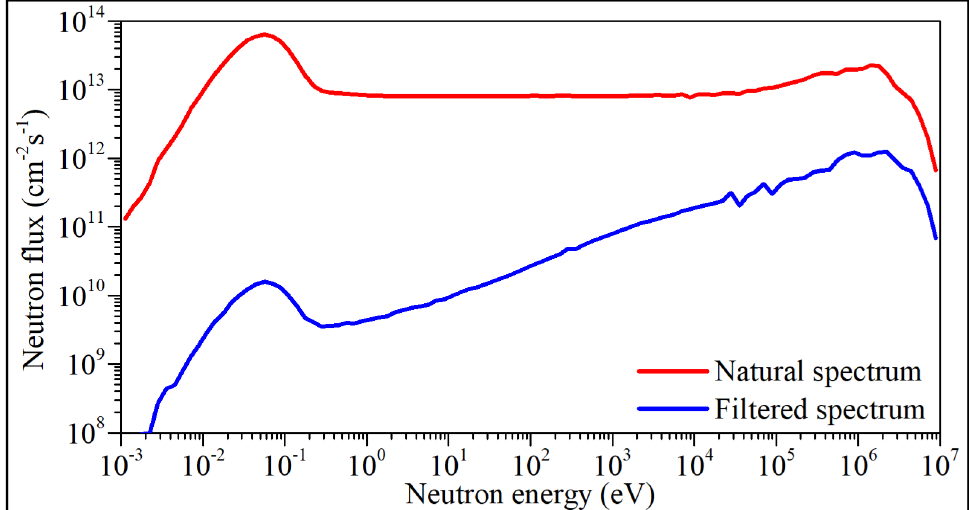
Figure 2. Natural and filtered energy spectra of the MARIA nuclear research